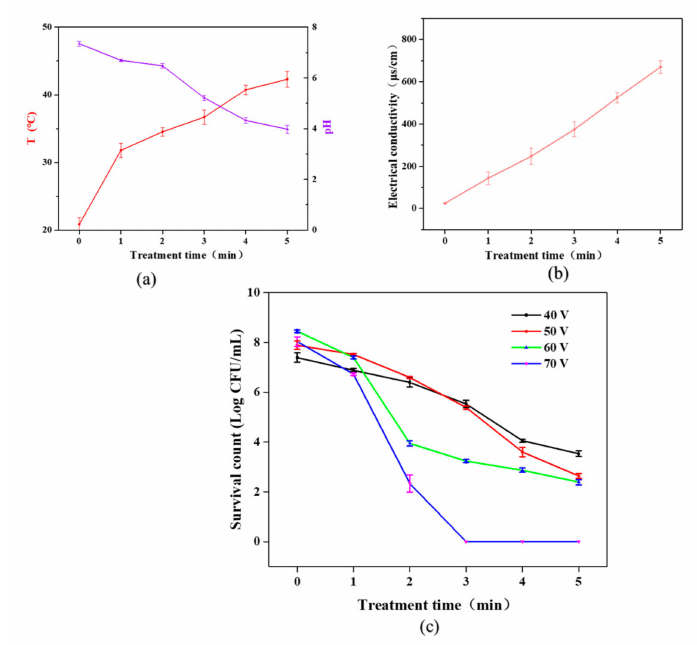
Figure 2. Effects of cold plasma treatment on S. typhimurium suspension. ( a ) Temperature changes; ( b ) electrical conductivity changes; ( c ) total number of S. typhimurium colonies